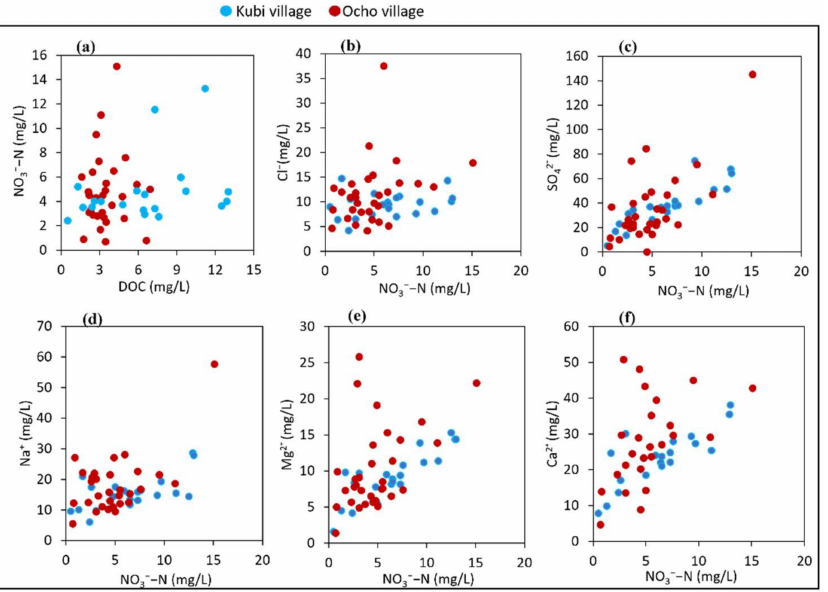
Figure 6. Relationship between NO 3 − − N and ( a ), DOC, ( b ), Cl − , ( c ), SO 42 − , ( d ), Na + , ( e ), Mg 2+ , and ( f ), Ca 2+ in groundwater samples of Kubi and Ocho